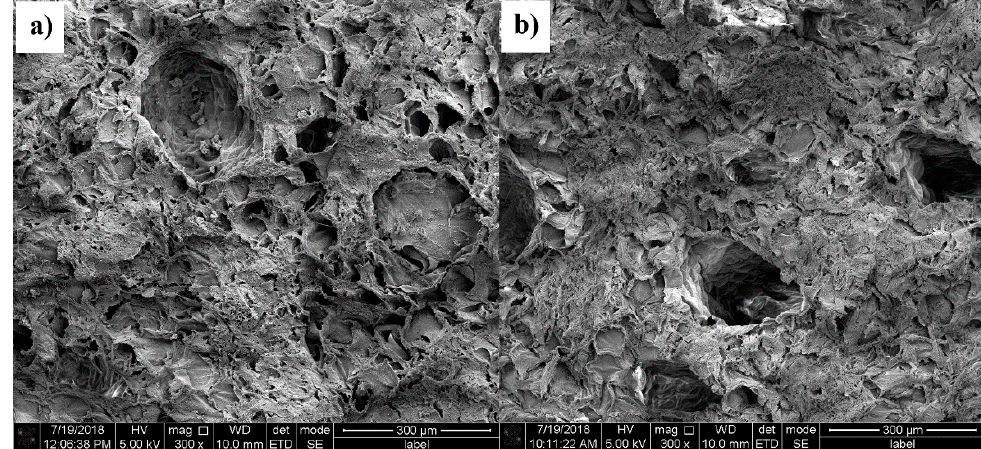
Figure 4. FESEM micrograph of cross-section stem: ( a ) control; ( b ) Ni exposure.